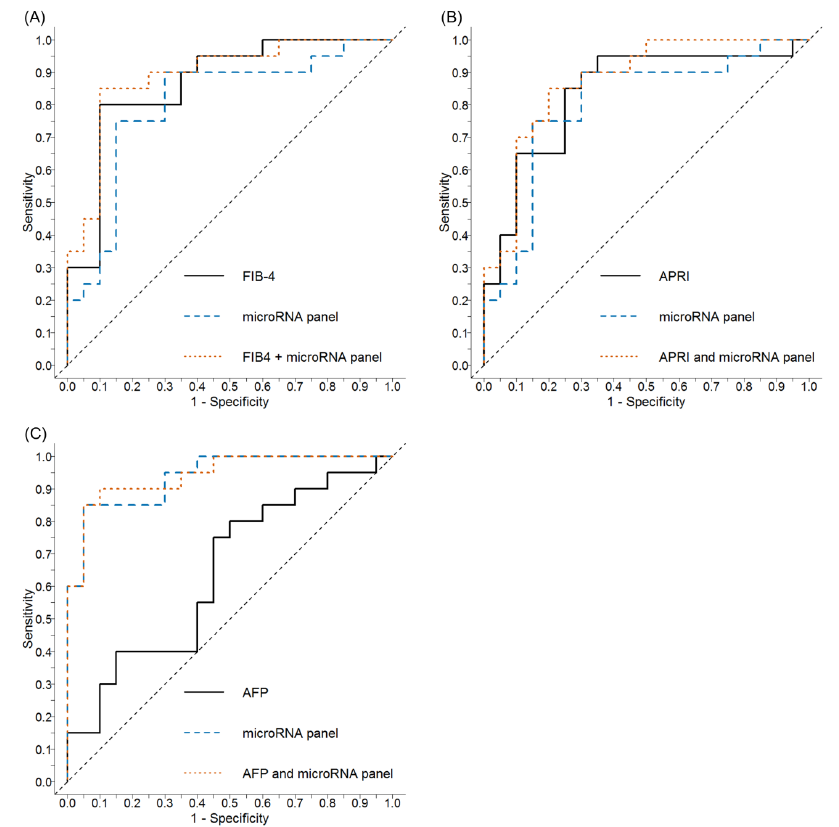
Figure 5. ROC curves to identify cirrhosis or HCC using FIB-4 or APRI alone, or in combination with circulating miRNA panels in chronic Hepatitis C. ( A ) In distinguishing cirrhosis, the performance of FIB-4 (AUC = 0.87, 95% CI 0.75–0.98, p < 0.001; using a cut-off of >1.45 to exclude advanced fibrosis) was enhanced in combination with the cirrhosis miRNA panel described in Figure 3A (AUC = 0.89, 95% CI 0.79–0.99, p < 0.001); ( B ) in distinguishing cirrhosis, the performance of APRI (AUC = 0.84, 95% CI 0.71–0.97, p < 0.001; using a cut-off of >1.0 to exclude cirrhosis) was enhanced in combination with the cirrhosis miRNA panel described in Figure 3A (AUC =0.87, 95% CI 0.76–0.98, p < 0.001); ( C ) AFP alone demonstrated poor diagnostic utility in the detection of HCC (AUC = 0.64, 95% CI 0.47–0.82, p = 0.065; using a cut-off of >20 to diagnose HCC) and when used in combination with the HCC miRNA panel described in Figure 3B there was no improvement in the HCC miRNA panel’s ability to detect HCC (AUC = 0.94, 95% CI 0.88–1.00, p < 0.001). (Abbreviations: APRI = aspartate aminotransferase to platelet ratio; AFP = alpha-fetoprotein; AUC = area under the curve; FIB-4 = Fibrosis-4 biomarker panel; HCC = hepatocellular carcinoma; miRNA = microRNA; ROC = receiver operating characteristic; 95% CI = 95% confidence